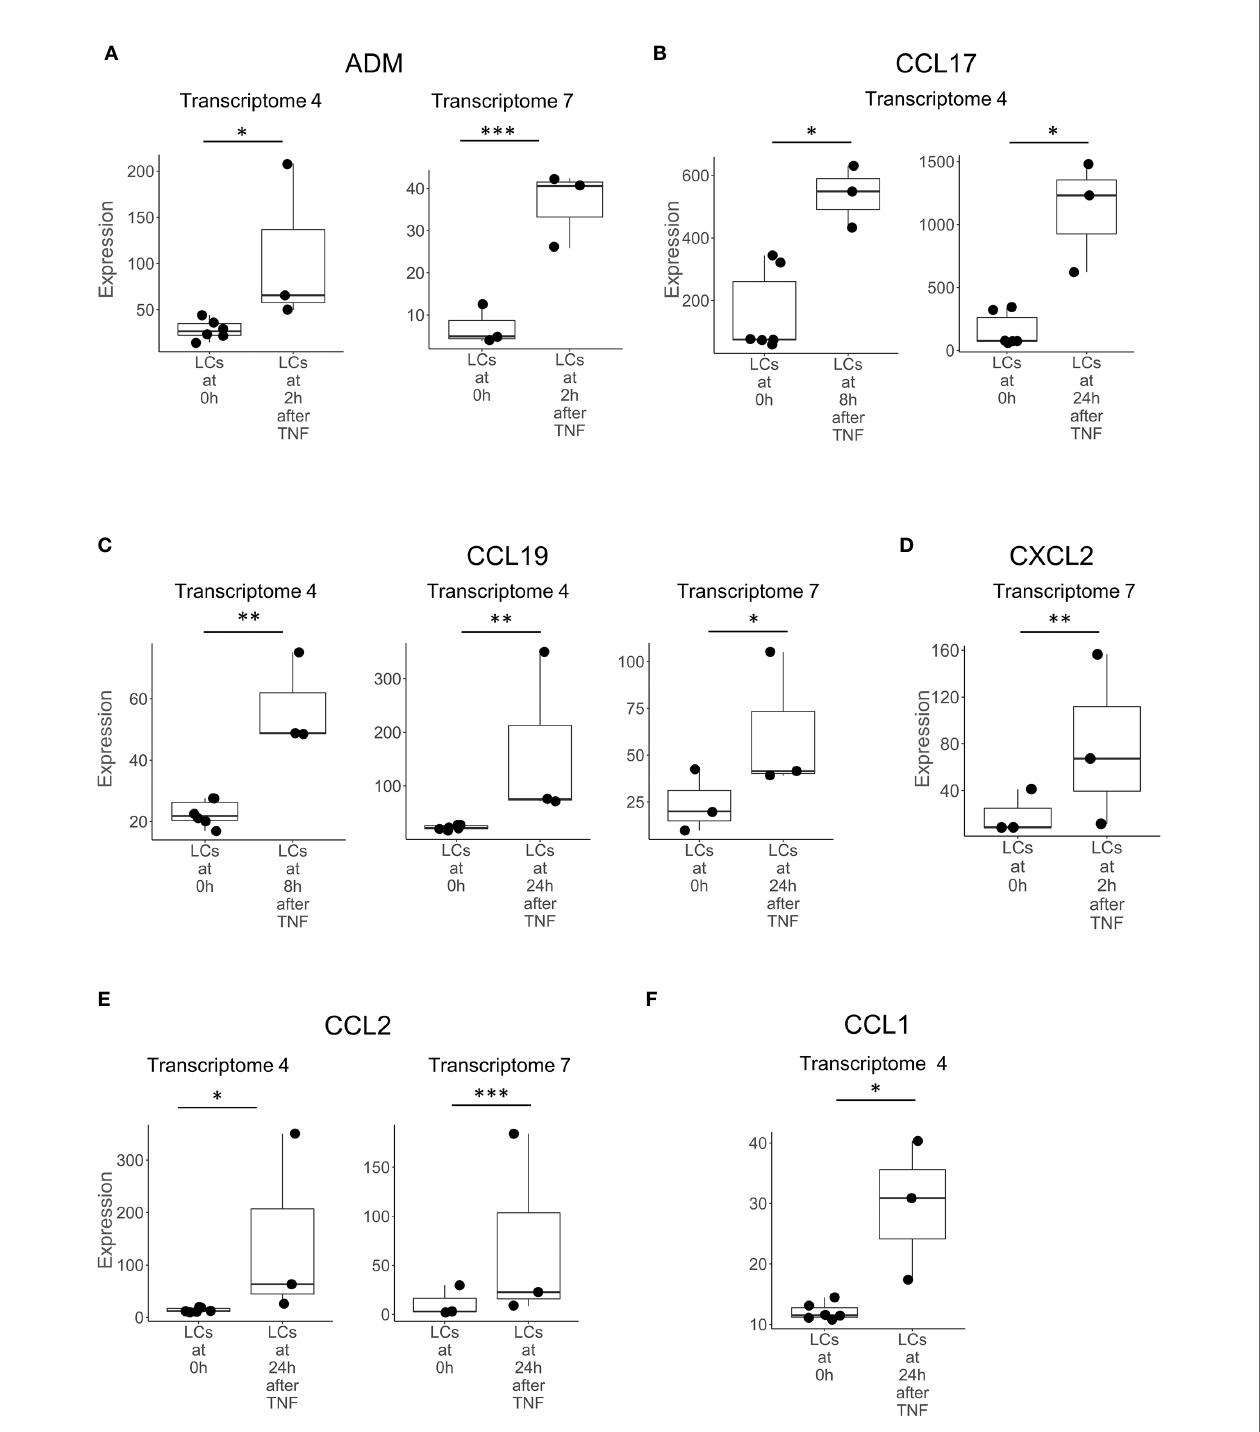
FIGURE 1 | Genes upregulated in LCs after activation with TNF. Boxplots showing the expression of (A) ADM , (B) CCL17 , (C) CCL19 , (D) CXCL2 , (E) CCL2 , and (F) CCL1 , encoding antimicrobial peptides in LCs prior to (0h) and at various time points following activation with TNF in transcriptomes 4 and 7. Genes shown above were identi fi ed in at least two instances, either in multiple transcriptomes experiments or in one transcriptome experiment but also identi fi ed in LCs in non- transcriptome experiments in the literature. *p < 0.05, **p < 0.01, ***p <